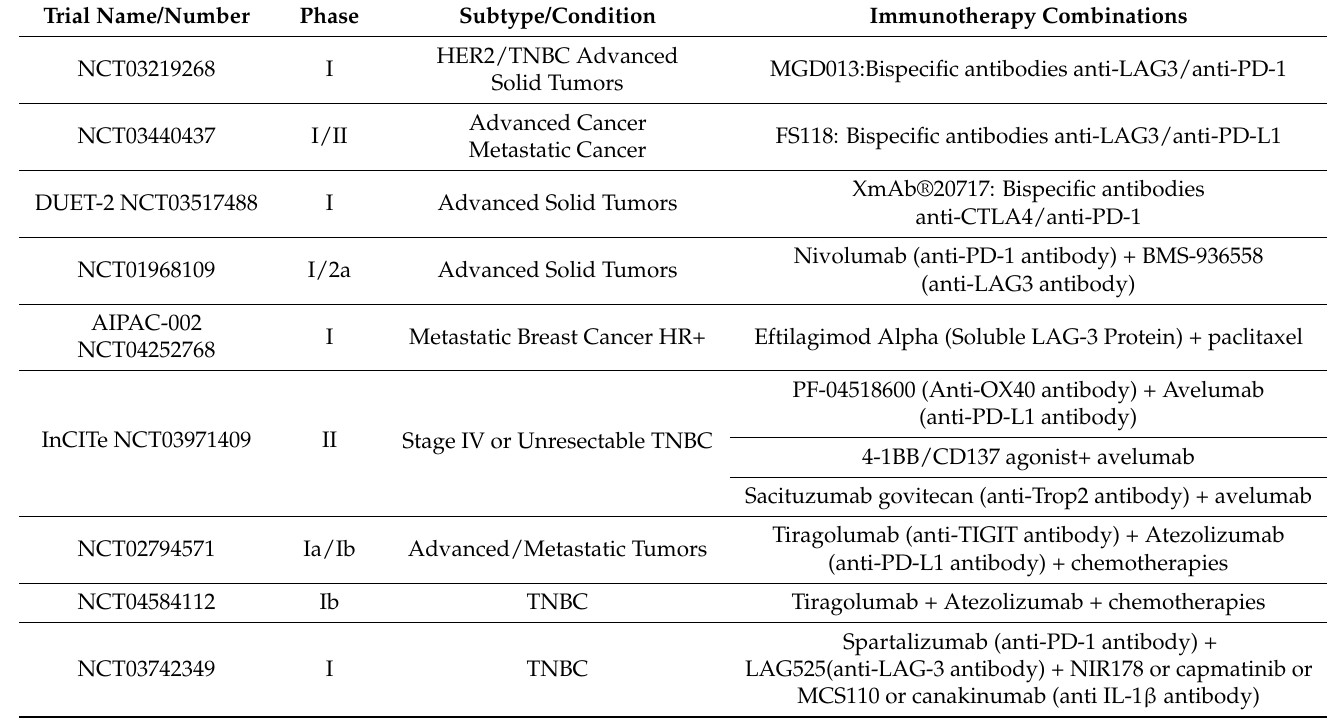
Table 1. Immunotherapy combinations in clinical trial including anti-PD-(L)1